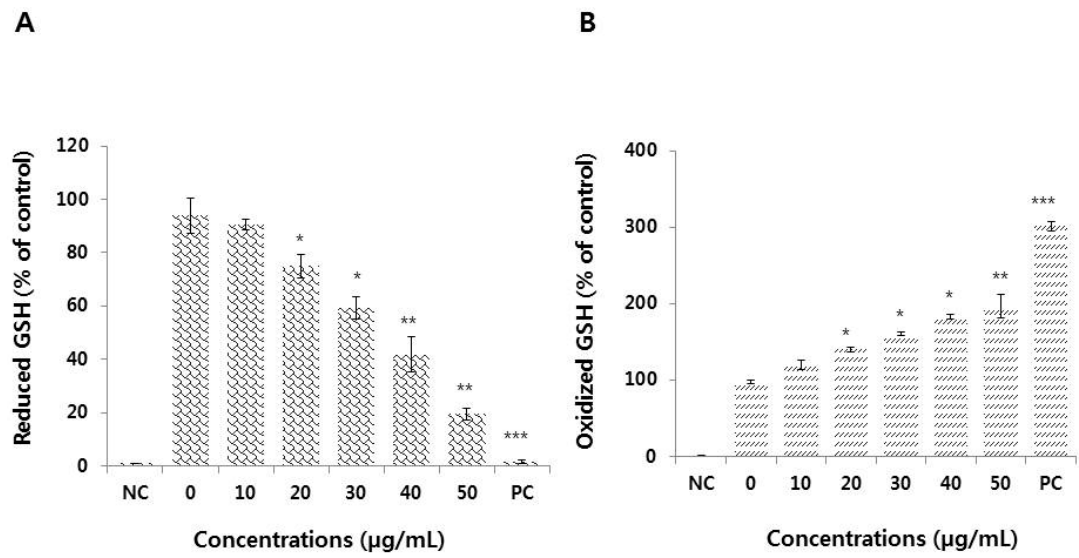
Figure 5. Measurement of antioxidant levels in HEK293 cells. Cells were treated with various concentrations of graphene oxide for 24 h. After incubation, the cells were harvested, washed twice with ice-cold PBS, and then disrupted by ultrasonication for 5 min on ice. ( A ) The concentration of glutathione (GSH) was expressed as mg/g of protein. ( B ) The concentration of oxidized glutathione (GSSG) was expressed as mg/g of protein. The results are expressed as means ± standard deviation of three independent experiments. Treated cells showed statistically significant differences compared to untreated cells. * p < 0.05 was considered significant; ** p < 0.01 was considered highly significant and *** p < 0.001 was considered very highly significant.